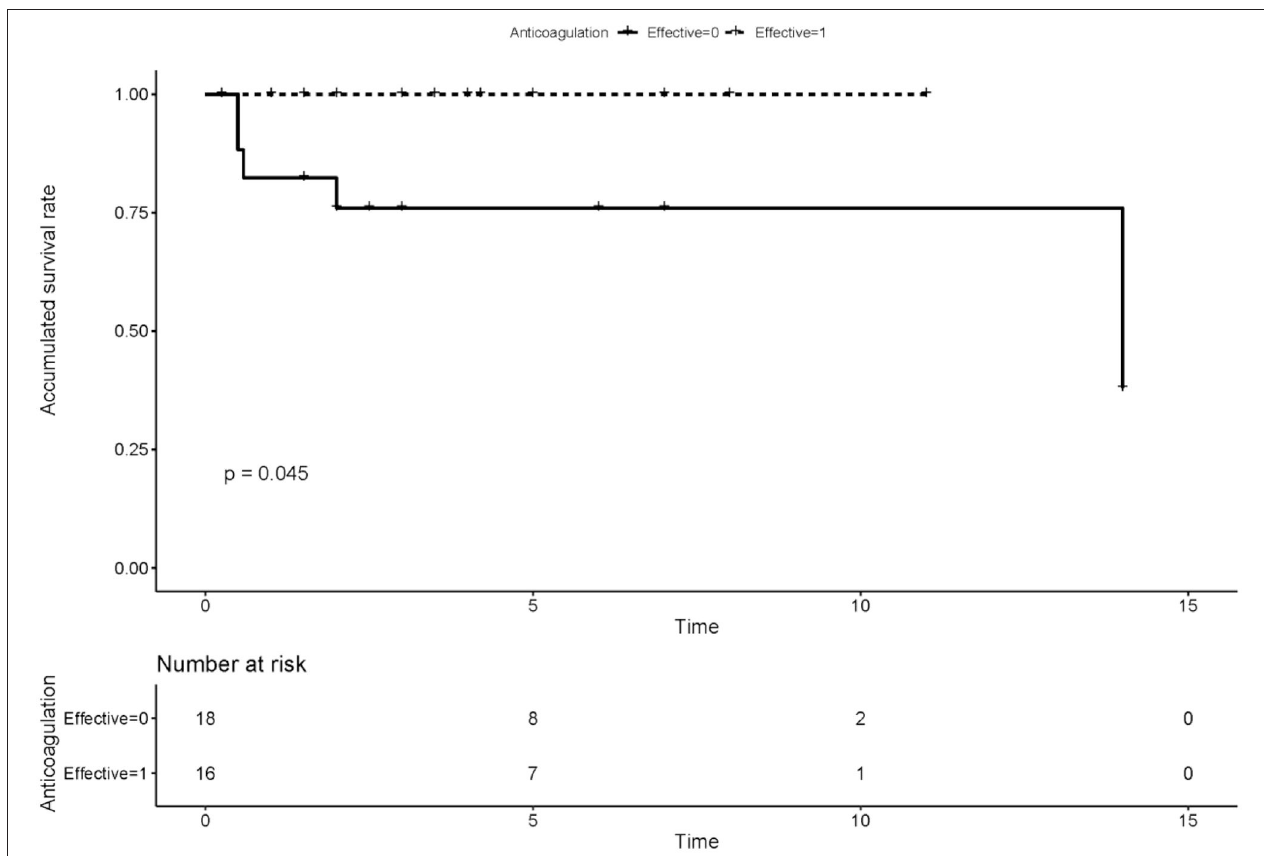
FIGURE 2 | Difference of accumulated survival rate between groups receiving effective anticoagulation ( n = 16) and not ( n = 18). Effective anticoagulation was defined as immediate and sufficient anticoagulant therapy for at least 6 months with a target international normalized ratio (INR) of 2.0–3.0 from the time of portal vein thrombosis (PVT)